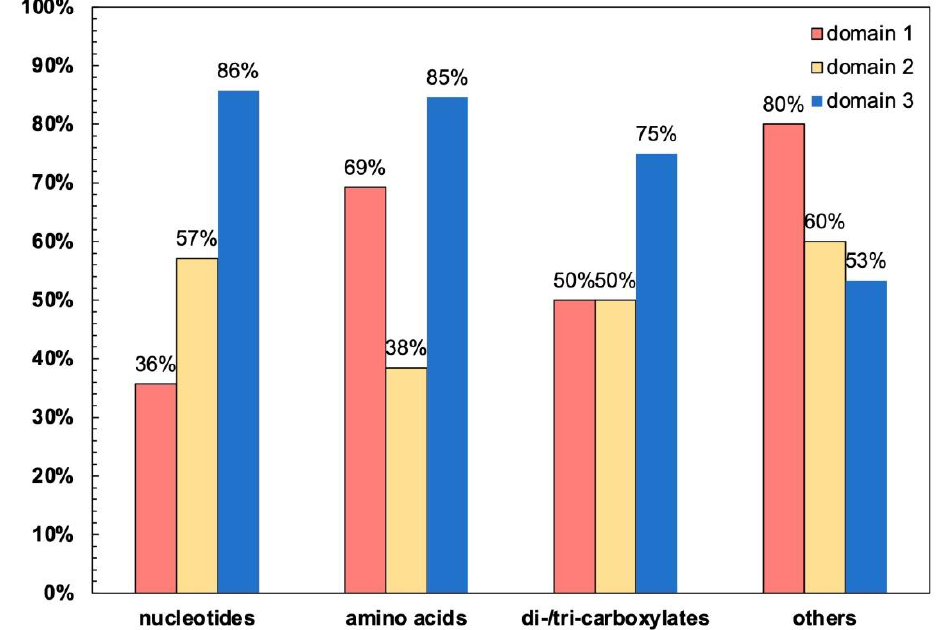
Figure 7. Frequencies of E in the [DE]G motifs of the three homologous domains in different groups of human MCs. Of a total of 53 human mitochondrial carriers, 46 were used for the calculation. Those carriers that are reported to localize outside the IMM (MTCH1, MTCH2, SLC25A46 and PM34) and those having an unexpected charged residue in the second position of the [DE]G motif (SLC25A47, SLC25A51 and SLC25A52) were excluded from the calculation. Please refer to Supplemental Table S1 for detailed information on the members of each group and the first residues of the [DE]G motifs in the three homologous domains of each carrier.